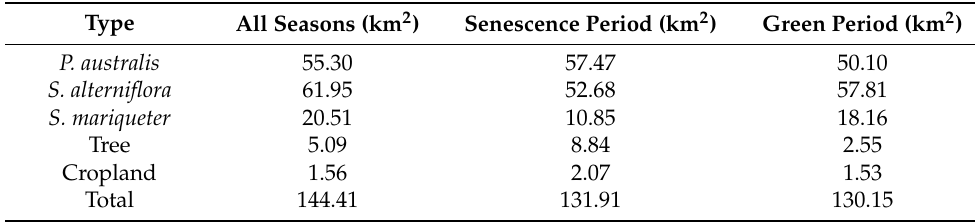
Table 6. Comparison of vegetation-type areas outside the Chongming Island dam extracted for all seasons, the senescence period, and the green period.